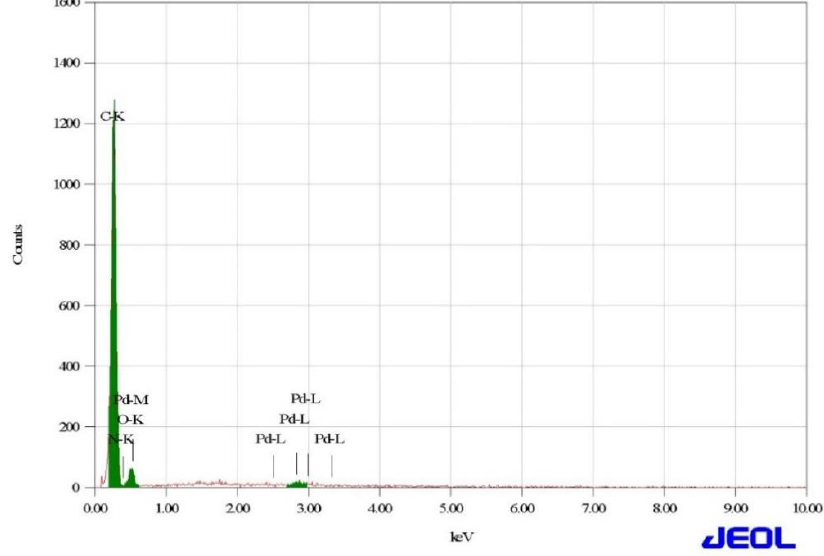
Figure 3. EDX analysis of 3% Pd/C.